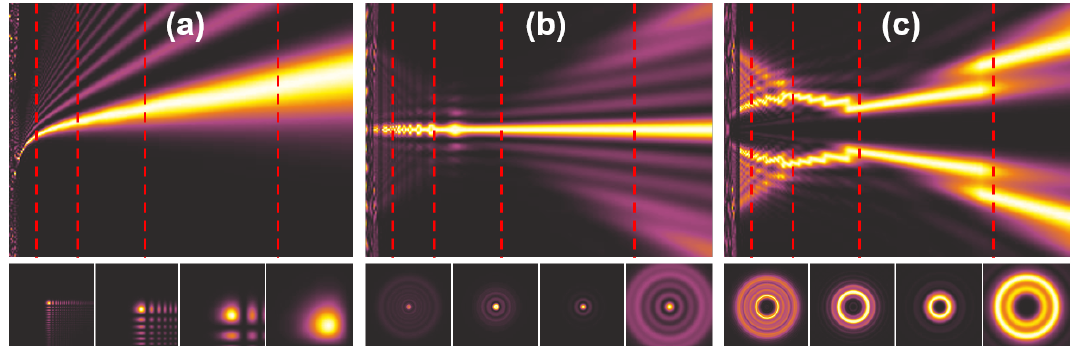
Figure 7. The intensity patterns of: ( a ) Airy, ( b ) Bessel and ( c ) optical vortex beams. The upper panel illustrates the propagation along optical axis— yz plane , while the lower panel corresponds to the xy cross-sections at distances after optical element marked with red dashed lines. The structure is located on the left edge of yz